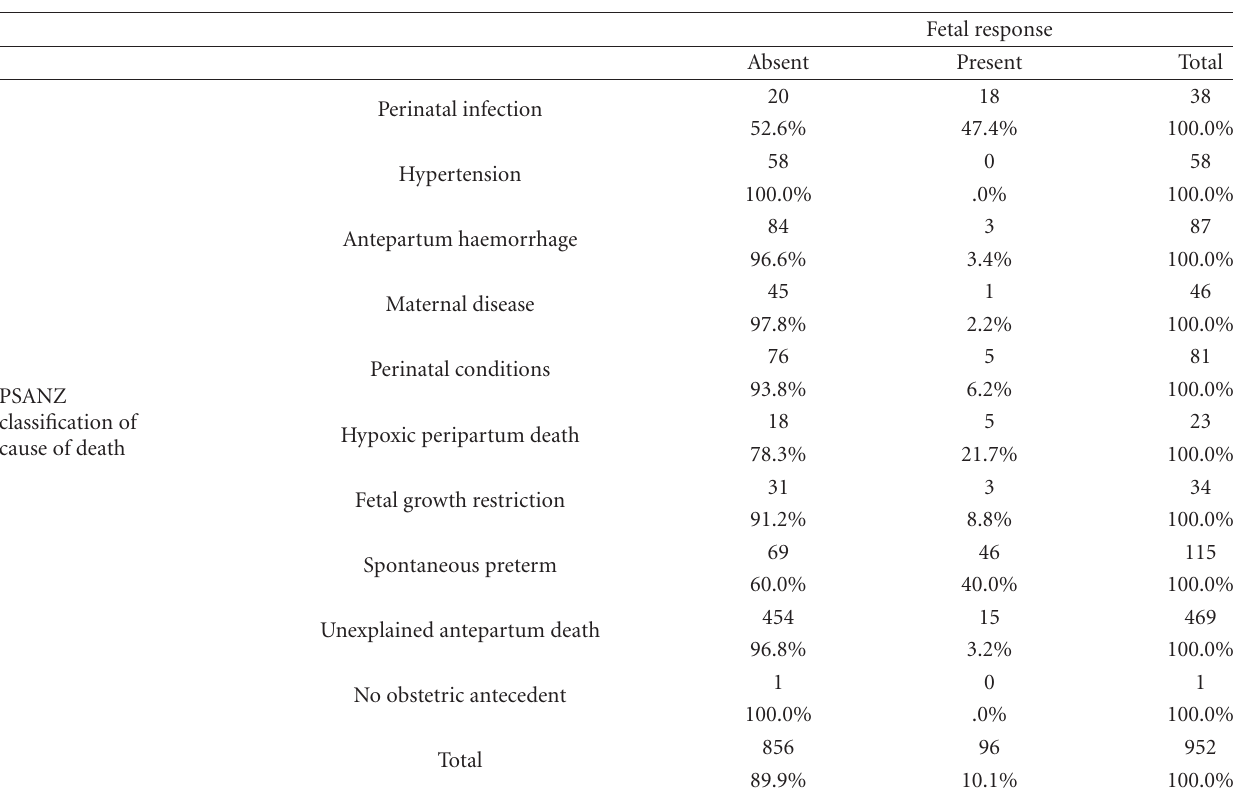
Table 3: Relationship of fetal response to cause of